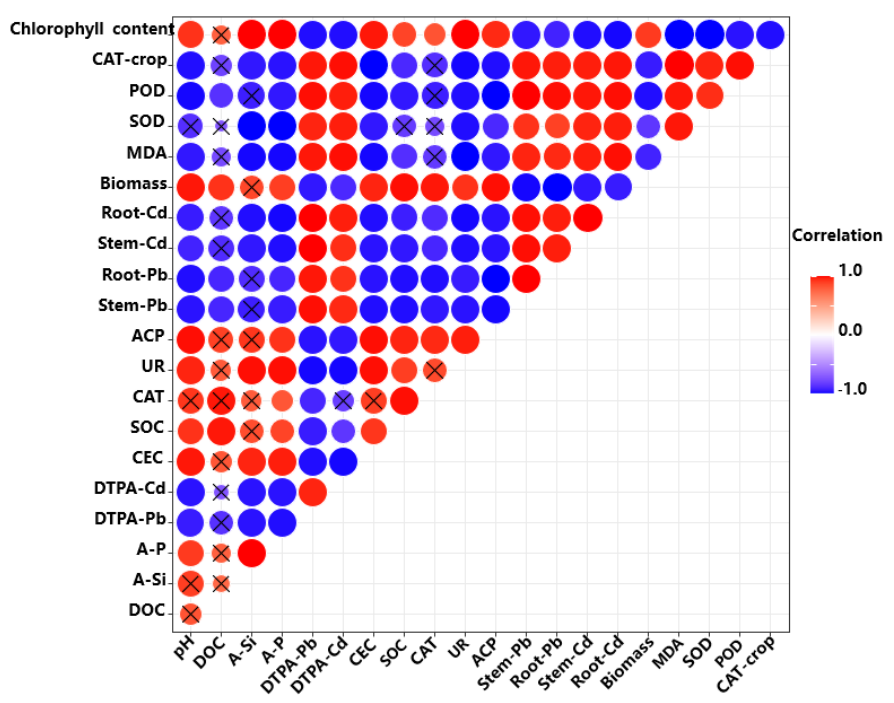
Figure 7. Pearson correlation coefficients for the relationships among the tested parameters of pak choi and soil ( n = 5).